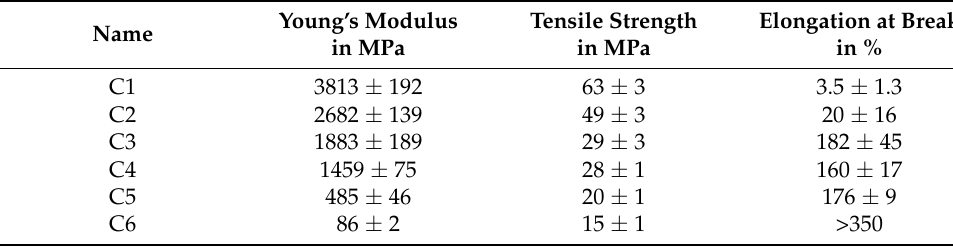
Figure 6. Complex viscosity of the compounds as a function of time. The characteristic values determined from the tensile tests for the compounds are shown in Table 4. Table 4. Determined mechanical properties of the compounds.